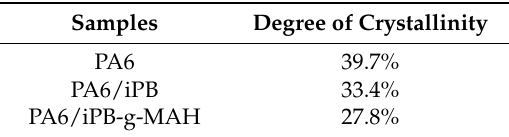
Figure 16. SEM fractographs of different samples: ( a )( b ) PA6; ( c )( d ) iPB/PA6 blends; ( e )( f ) iPB-g- MAH/PA6 blends.